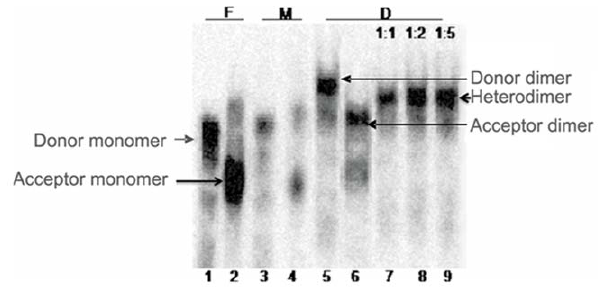
Figure 7. Efficiency of heterodimerization between the accep- tor and donor transcripts. The acceptor and donor transcripts were incubated in Formamide, monomer and dimerization buffers, similar to the dimerization assay. The efficiency of heterodimerization between the donor and acceptor was performed by adding molar excess (as indicated at the top of the gel) of unlabelled acceptor transcript to labeled donor transcript under optimal dimerization conditions. All samples were analyzed on the 4% non-denaturing TBE gel. Lane 1: Donor transcript, Lane 2: Acceptor transcript, Lane 3: Donor transcript, Lane 4: Acceptor transcript, Lane 5: Donor transcript, Lane 6: Acceptor transcript, Lane 7–9: Donor transcript with increasing concentration of unlabeled acceptor transcript (1:1, 1:2, and 1:5). F- Formamide buffer, M- monomer buffer and D-dimerization buffer (with 5 mM MgCl 2 ).